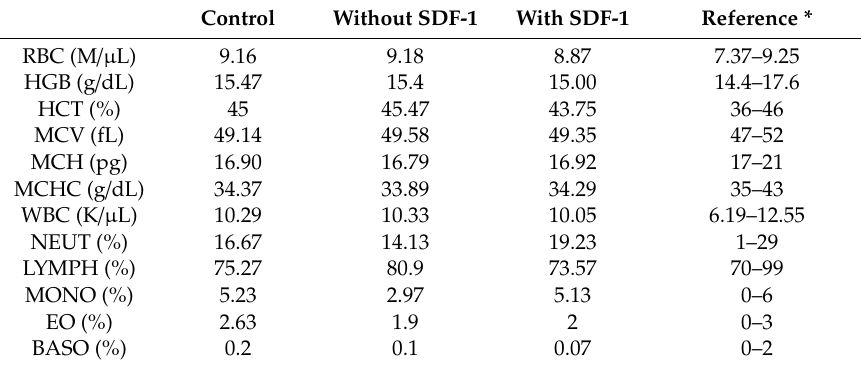
Table 4. Whole blood test (two